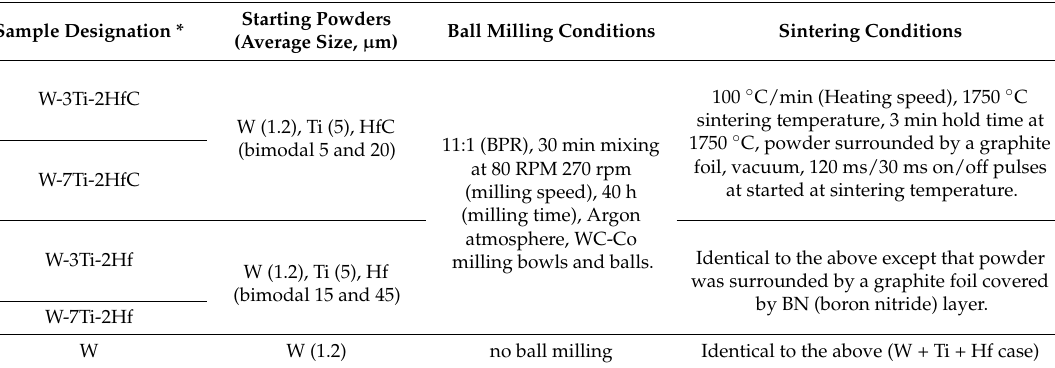
Table 1. Summary of the materials and production